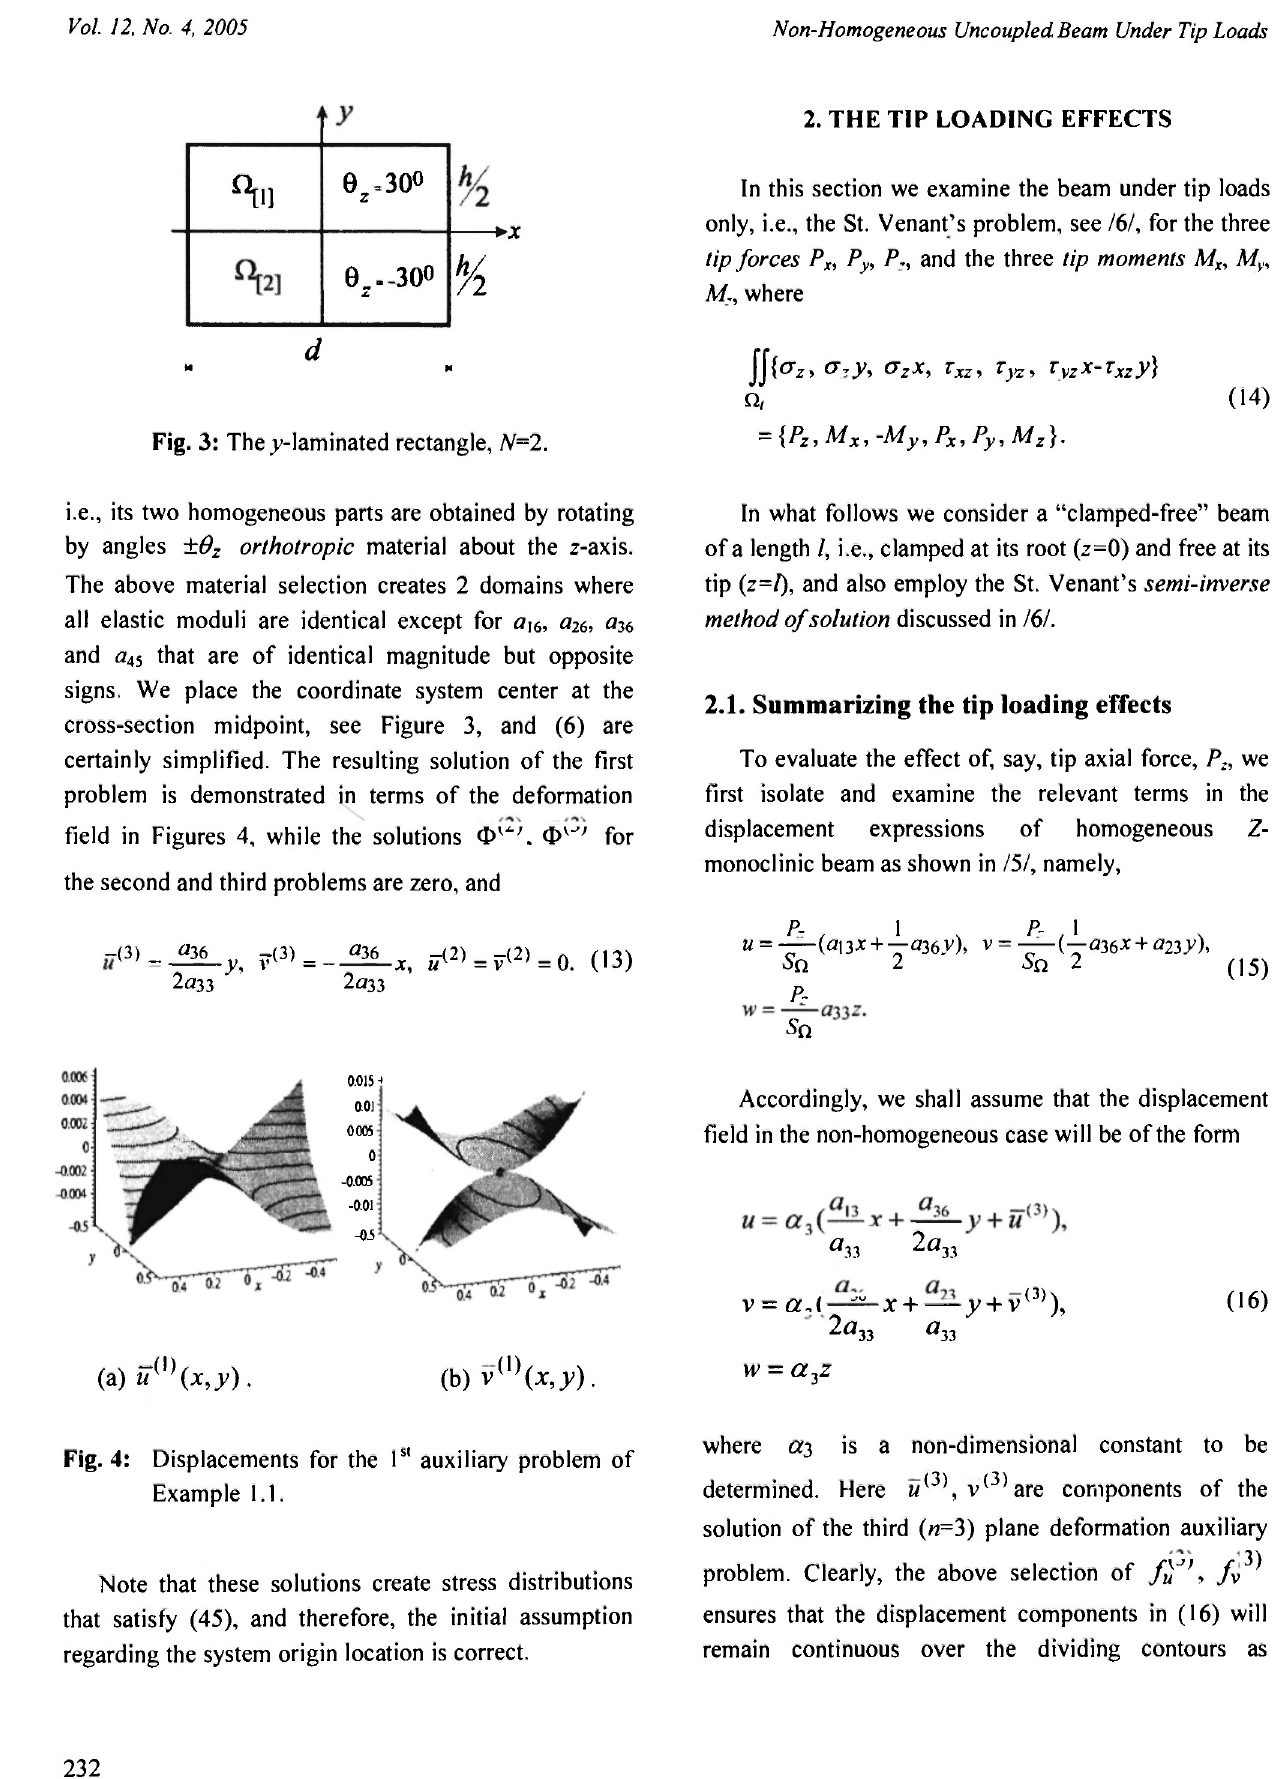
Fig. 3: The ^-laminated rectangle, N=2.